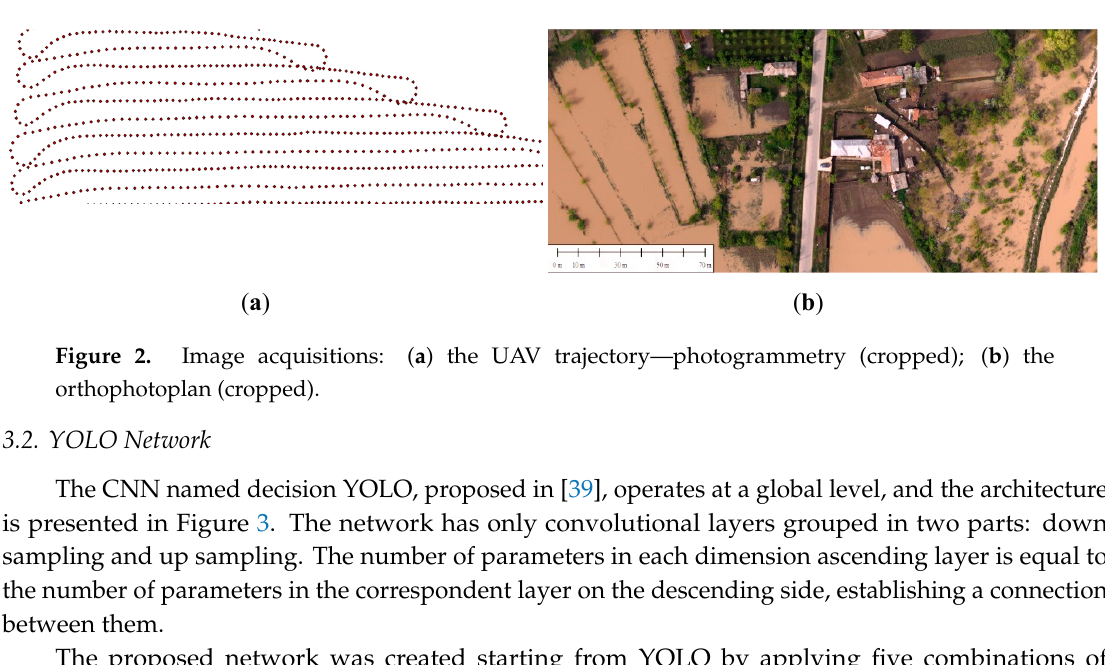
Table 1. UAV—characteristics and technical specifications.